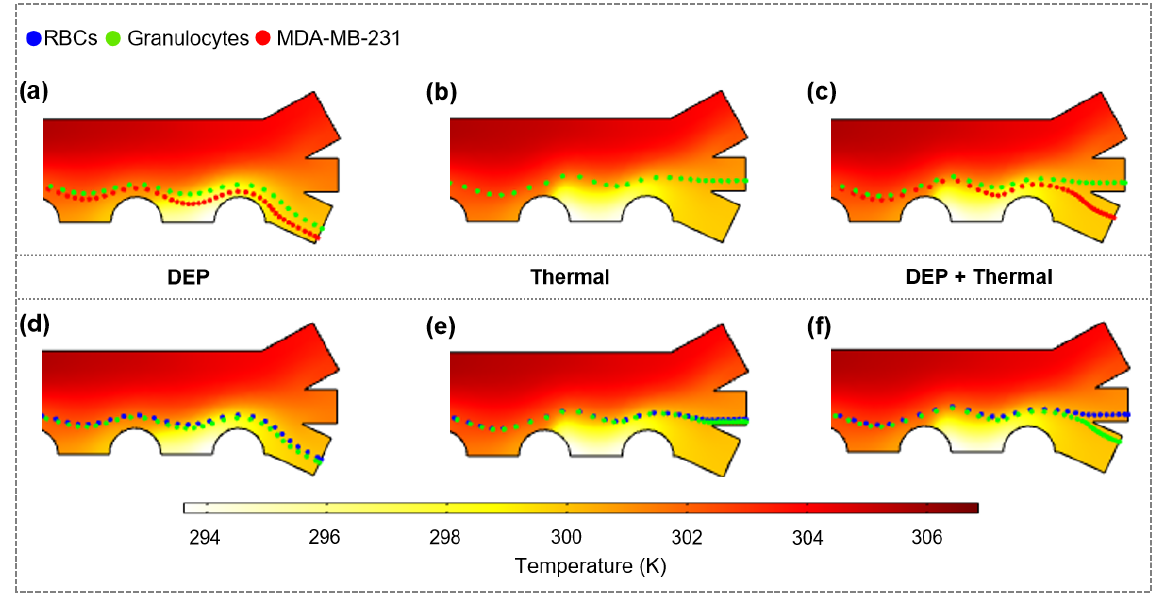
Figure 9. Simulated isolation of MDA-MB-231 from Granulocytes ( U 0 = 62 V eff , f = 10 kHz) as well as separation of RBCs and Granulocytes ( U 0 = 59 V eff , f = 25 kHz) with temperature distribution as backgrounds. ( a , d ) Only DEP force; ( b , e ) only heat flow; ( c , f ) combined effects of DEP and heat flow. u 1 = 1.4 mm/s, u 2 = 1 mm/s, σ m = 0.002 S/m.